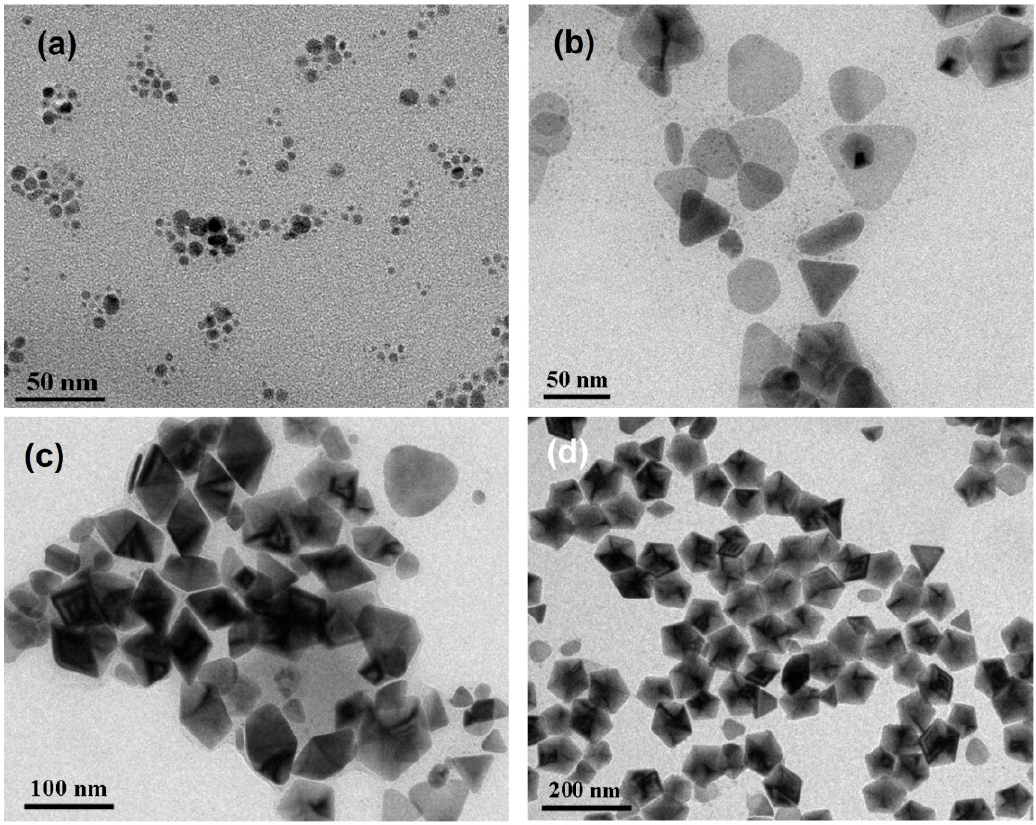
Figure 5. TEM images of the silver nanoparticles synthesized at 0 °C and at different reaction times: ( a ) 1.5 h; ( b ) 23 h; ( c ) 48 h and ( d ) 100